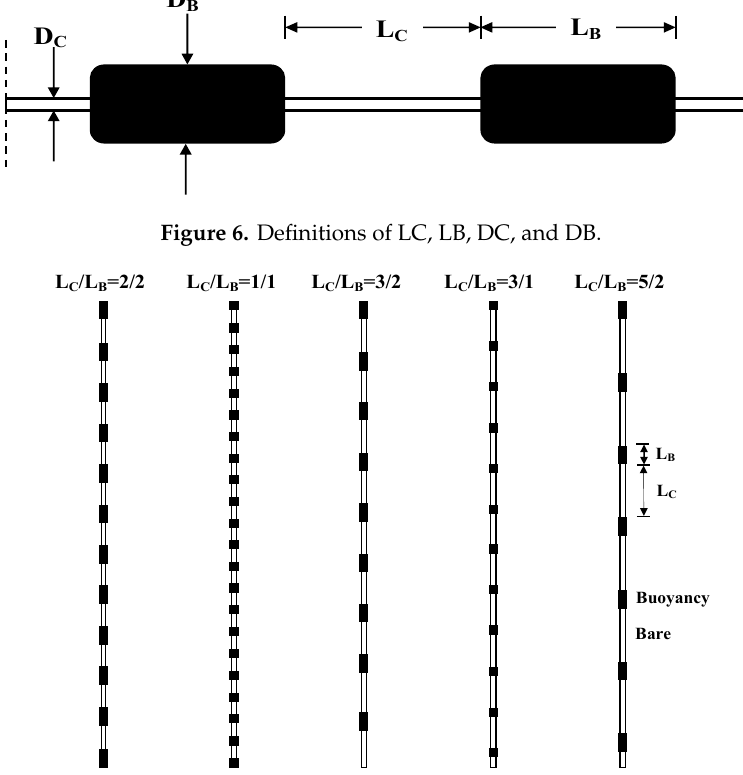
Figure 7. Staggered buoyancy configurations over the riser.